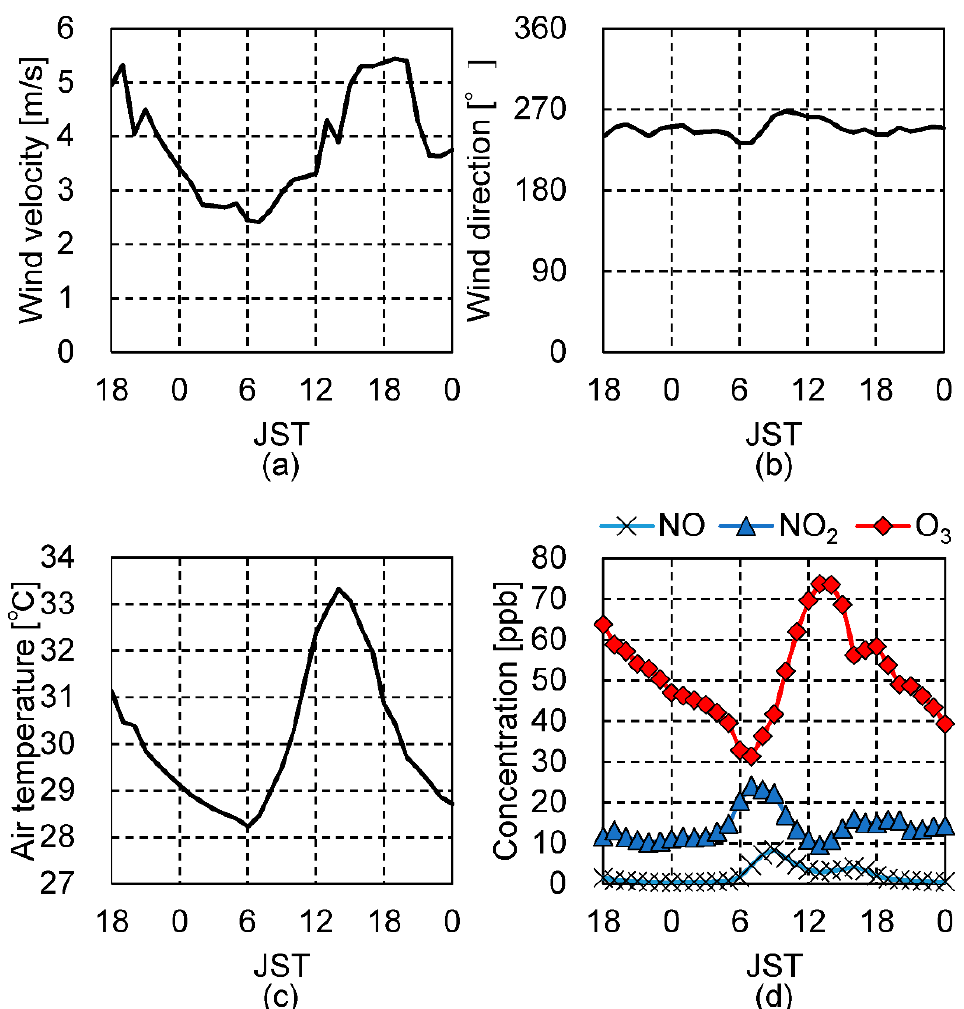
Figure 2. Diurnal variation of wind speed ( a ), wind direction ( b ) (0° means northern wind and 90° means eastern wind), air temperature ( c ) and pollutants concentrations ( d ) at height of around 29 m (the center of the first layer of WRF/CMAQ grids) from 18:00 August 22 to 24:00 August 23, 2010. The time is shown based on Japan standard time (JST).